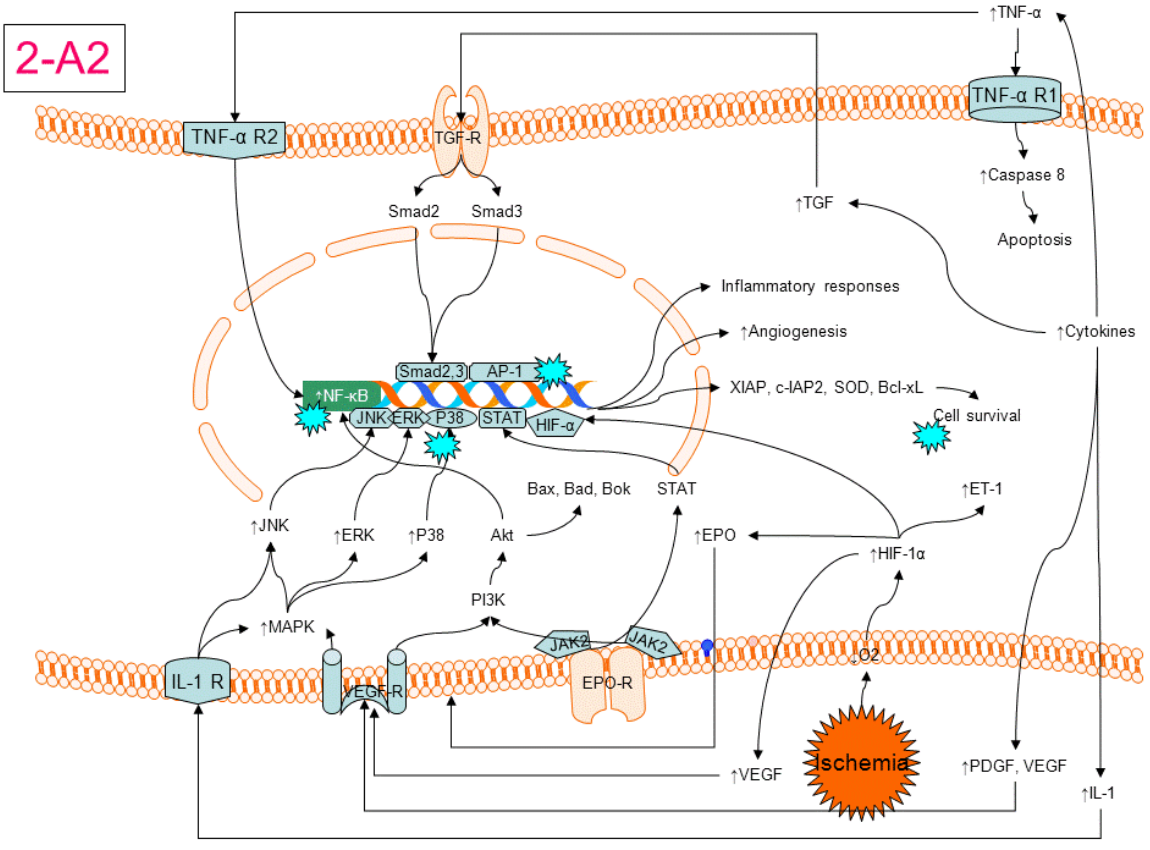
FIGURE 2-A2. Ischemic injuries occur in the capillary endothelium in genomic levels (green